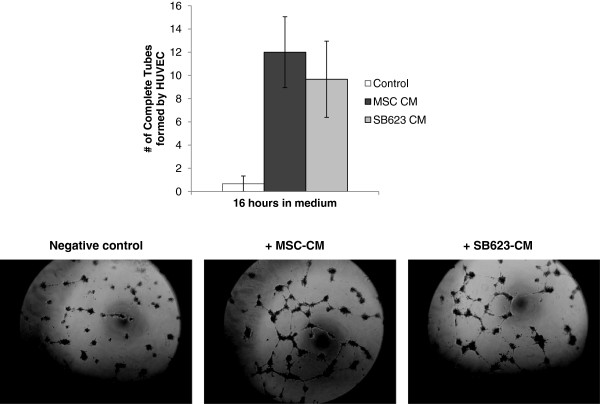
SB623 cell and MSC-conditioned medium enhances HUVEC tube formation. HUVECs were cultured with OptiMEM conditioned by either MSCs or SB623 cells or unconditioned OptiMEM (“Control”). Compared to unconditioned medium, there were more complete vascular tubes formed within 16 hours in the presence of conditioned medium (CM). The average number of completely-enclosed rings formed by the HUVECs (labeled “complete tubes”) in the entire well (96-well plate; 3–4 wells/group) is plotted. Mean ± SEM.